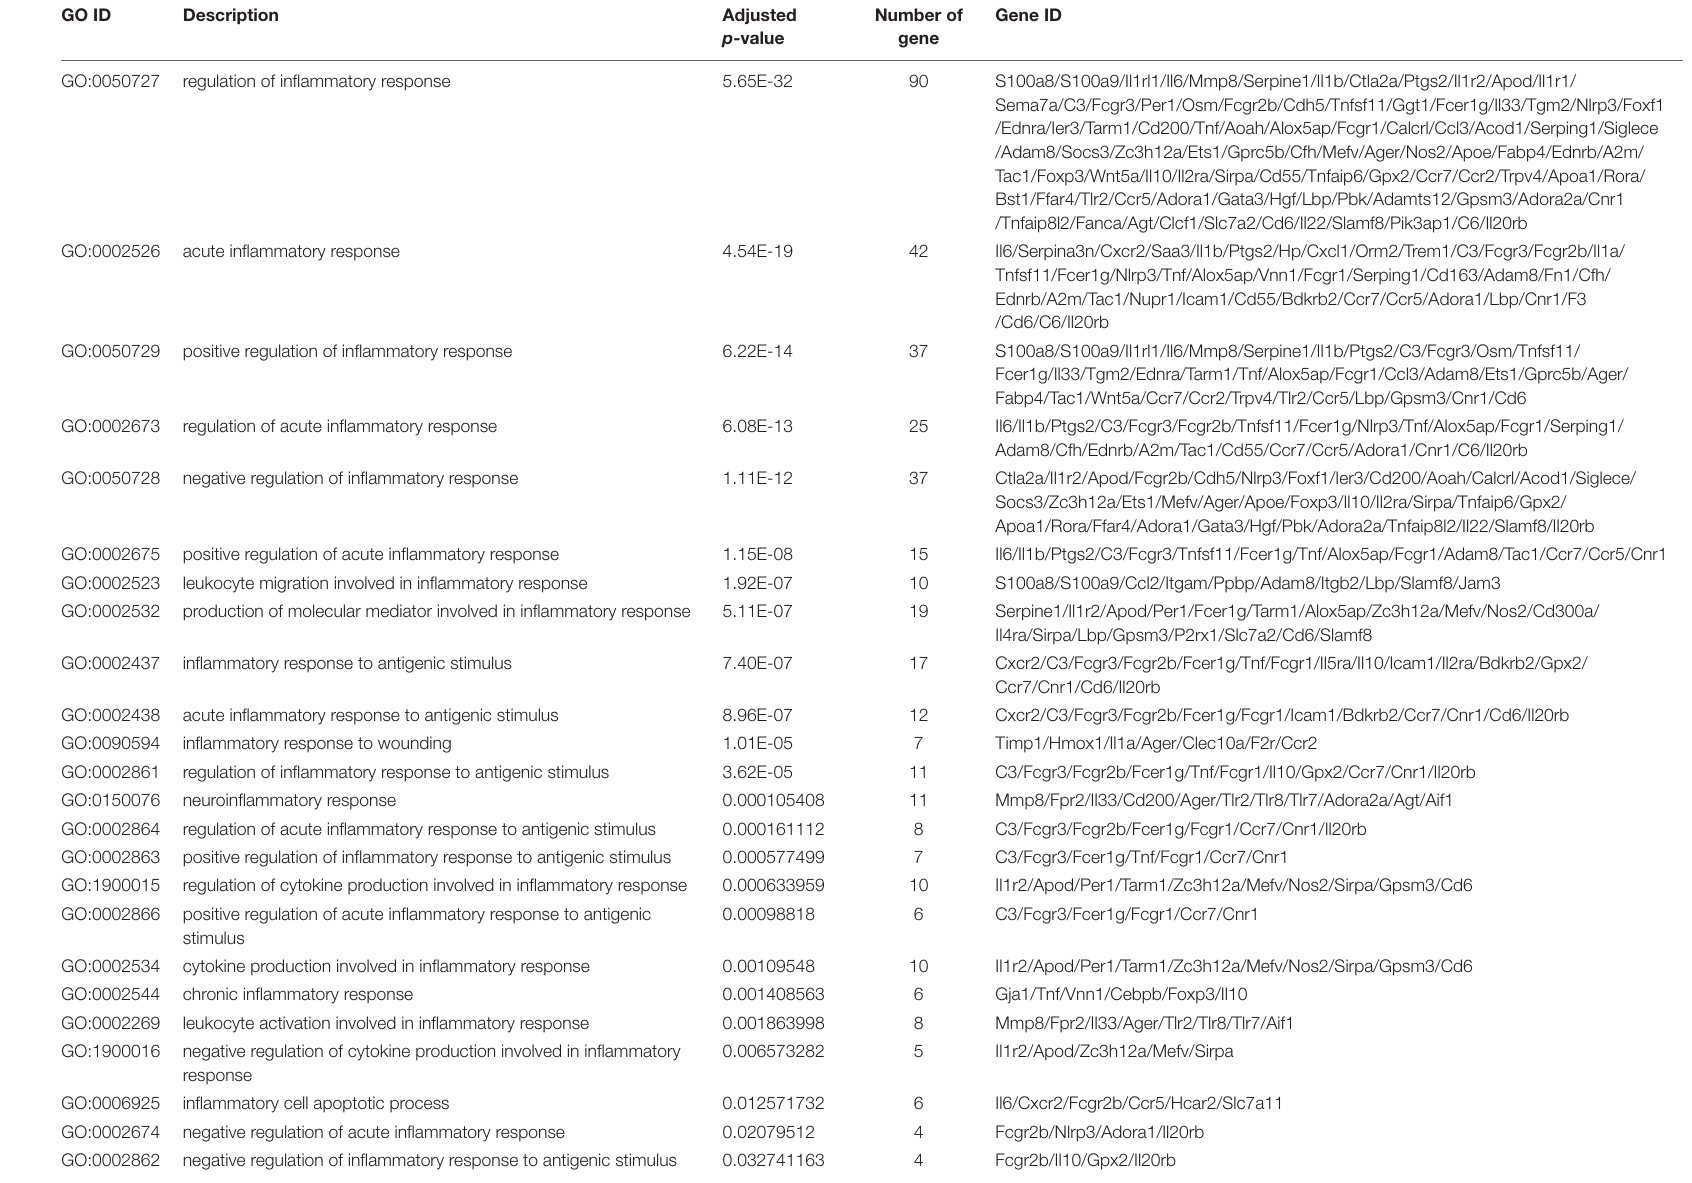
TABLE 1 | Inflammatory responses in gut caused by